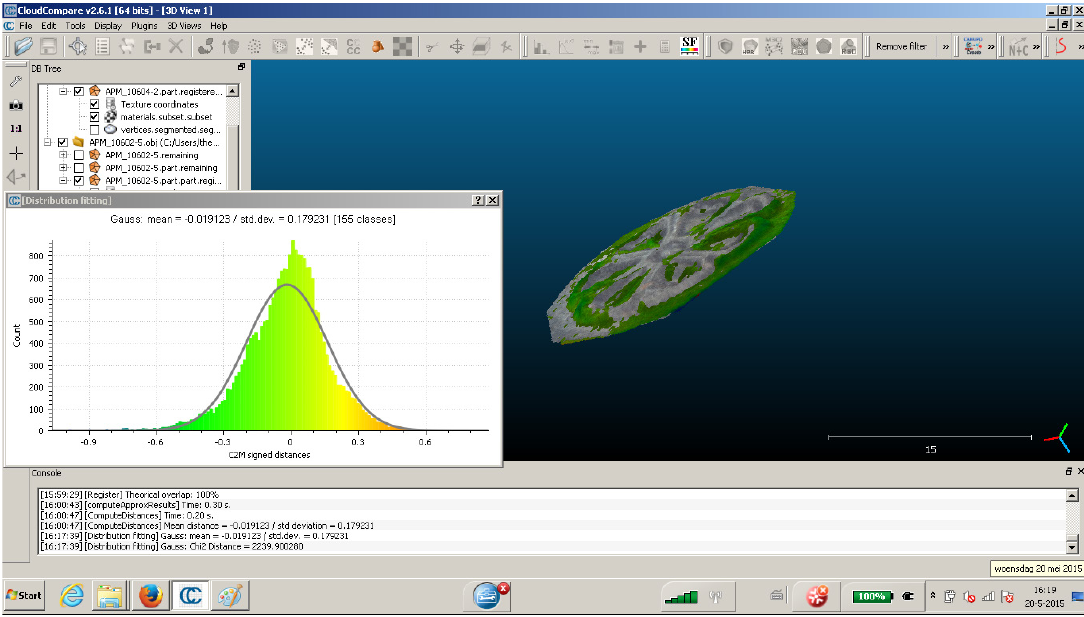
Figure 9. Visualizations of comparative analysis of stamps in CloudCompare. Illustration by I.